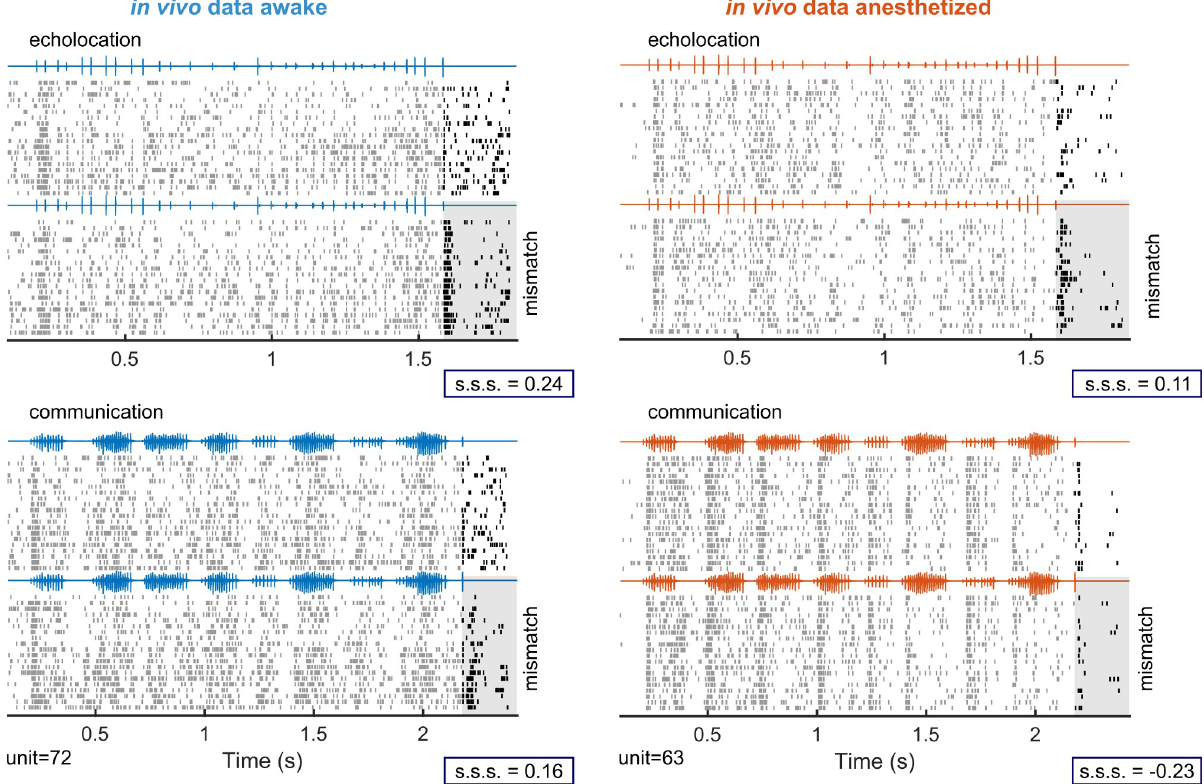
Fig 5. Examples of effects of anaesthesia on context-dependent processing in cortical neurons. Two example units illustrating cortical responses to natural sounds in awake (left) and anaesthetized (right) bats. Top: spiking responses to a sequence of echolocation pulses (context) followed by a matching probe sound (top 20 trials) and by a mismatching probe sound (bottom 20 trials). After a context sequence of echolocation pulses, matching and mismatching probe sounds correspond to a single echolocation pulse and a communication call, respectively. Bottom: the responses of the same neurons to a communication sequence followed by matching and mismatching probe sounds, i.e., a single communication call and by an echolocation pulse, respectively. The grey shaded area is used to highlight the response to the mismatching probe sound in both contexts. For each example unit and context, the respective value of stimulus-specific suppression (“s.s.s.”) is indicated.